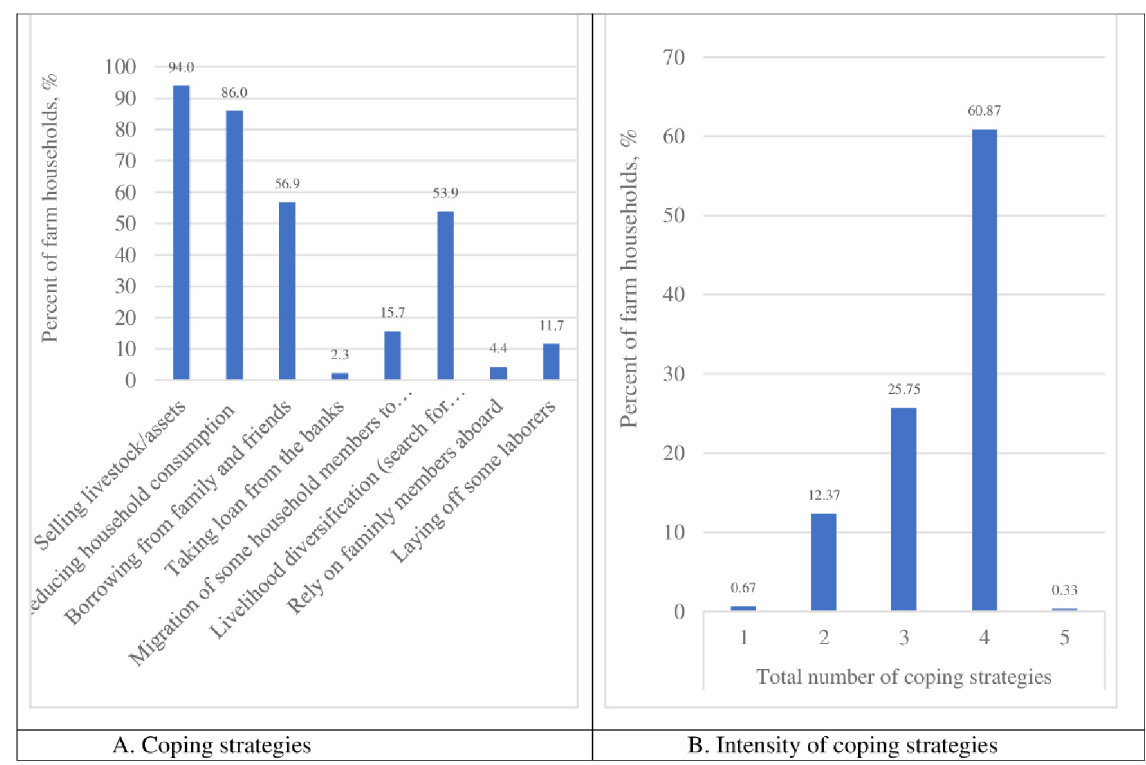
Fig 4. Coping with harvest failure by farmers in Northern Ghana. Source: Authors construct (based on household survey data).